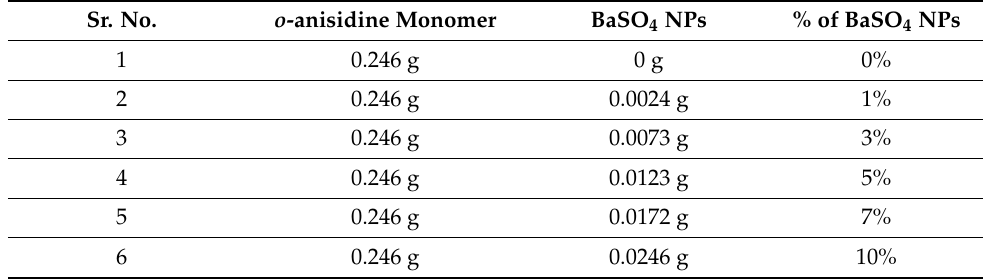
Table 1. Scheme for nanocomposite preparation. Sr.